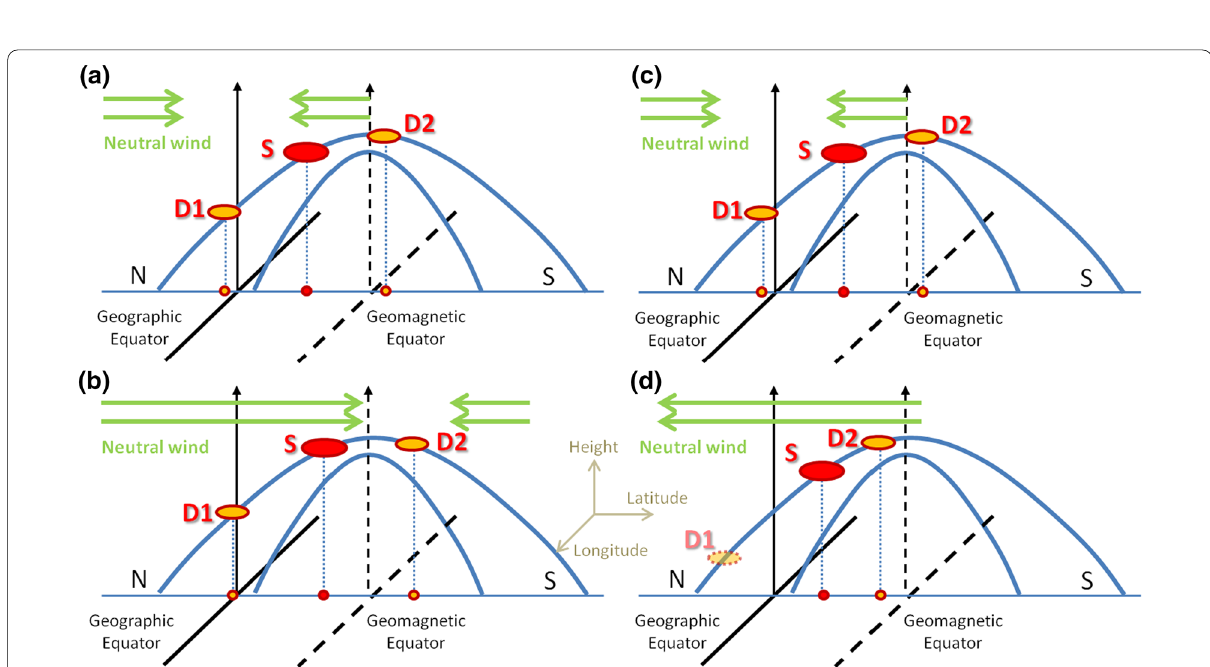
Fig. 8 The same as in Fig. 7, but at